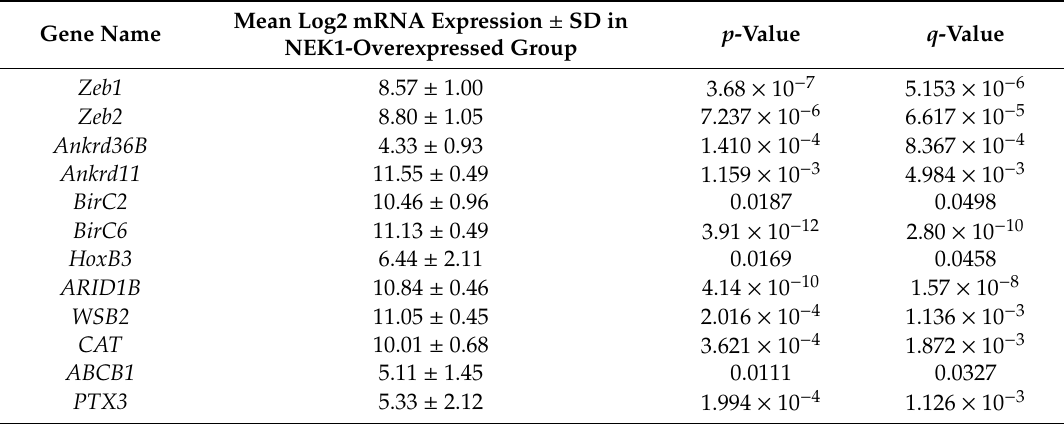
Table 1. Some of the YAP target genes significantly upregulated with NEK1 upregulation in head and neck squamous cell (HNSC) carcinoma (TCGA, firehose legacy) analyzed using